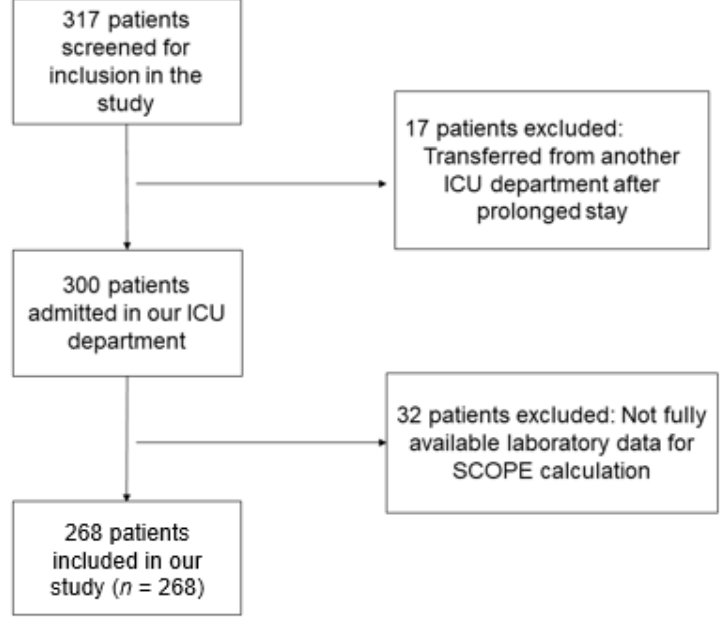
Figure 1. Flow chart of the study